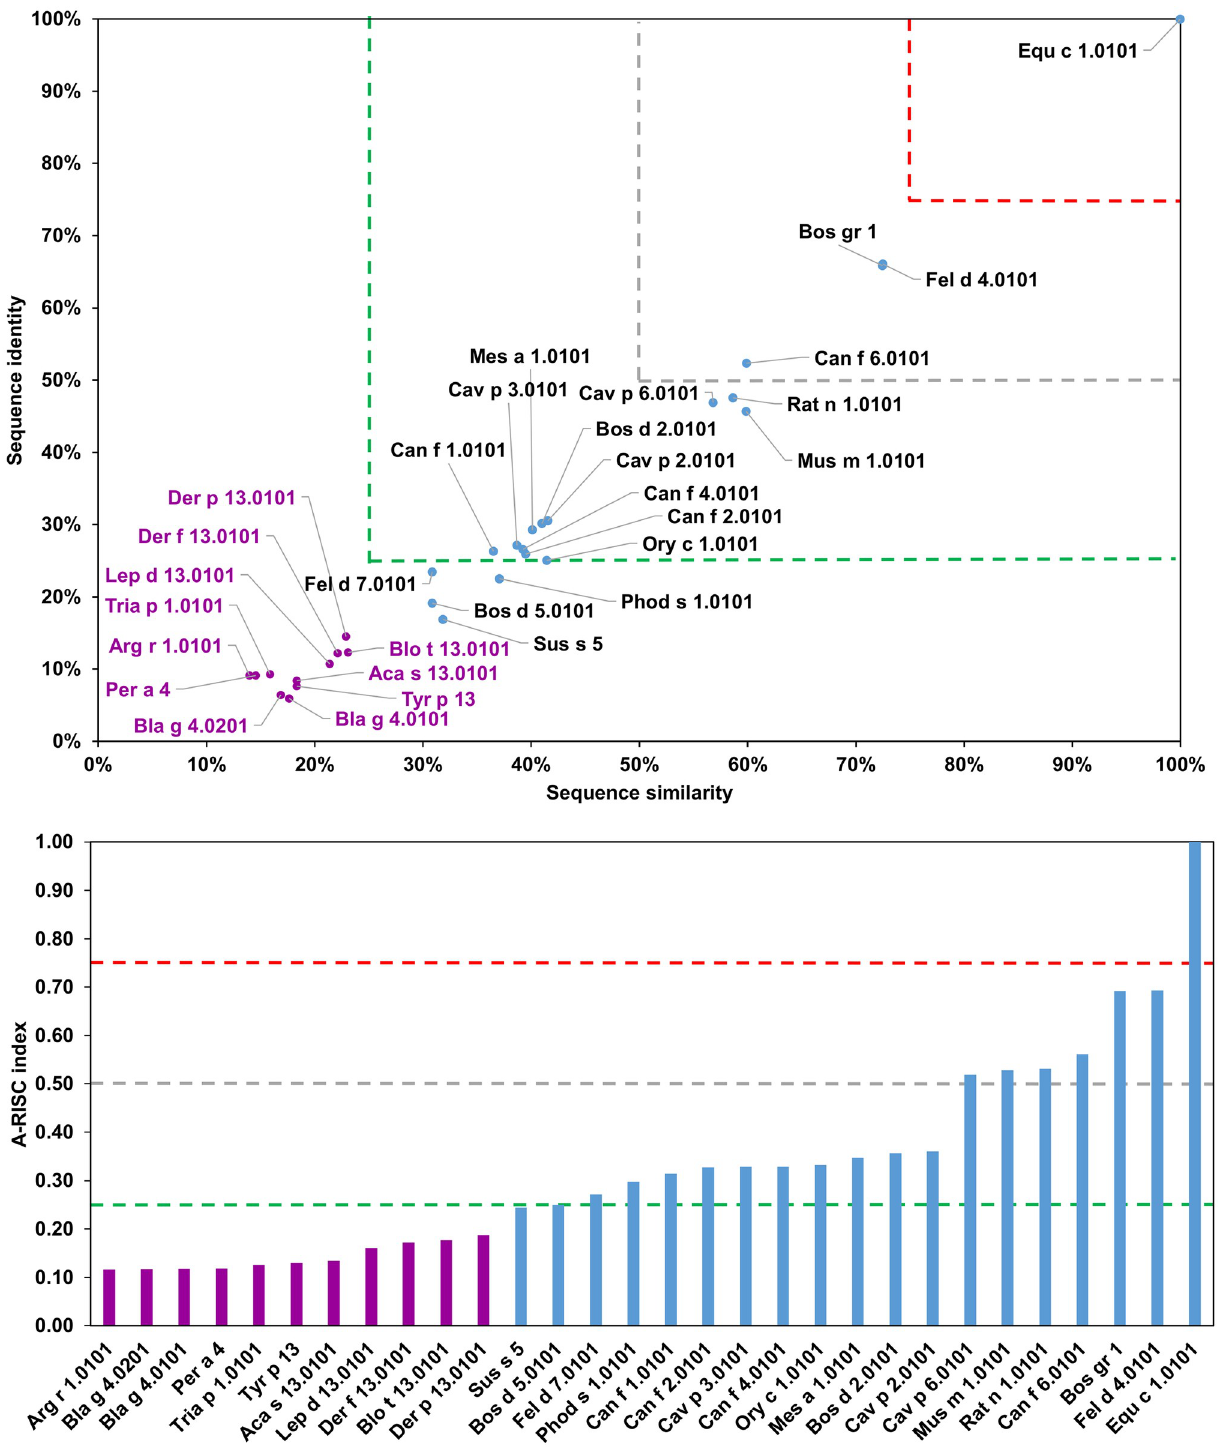
Fig 13. Plots showing relative homology and A-RISC indexes of allergens from lipocalin family of proteins. Comparison of family members to Equ c 1.0101. Allergens originating from Arthropods are marked in purple, while mammalian lipocalins are shown in blue. Red, gray, and dark green dashed lines indicate respectively 75%, 50% and 25% sequence identity and similarity, or 0.75, 0.50 and 0.25 A-RISC